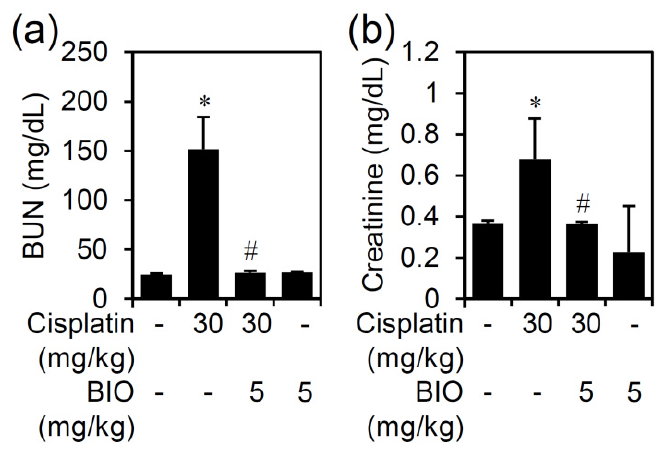
Figure 3. Inhibiting GSK-3 ameliorates cisplatin-induced AKI. Male C57BL/6 mice ( n = 3) were preinjected i.p. with the GSK-3 inhibitor BIO (5 mg/kg) for 0.5 h followed by cisplatin (30 mg/kg) for 24 h. Serum ( a ) BUN and ( b ) creatinine levels were determined. Quantified data are the mean ± SD. * p < 0.05 compared with untreated. # p < 0.05 compared with cisplatin.